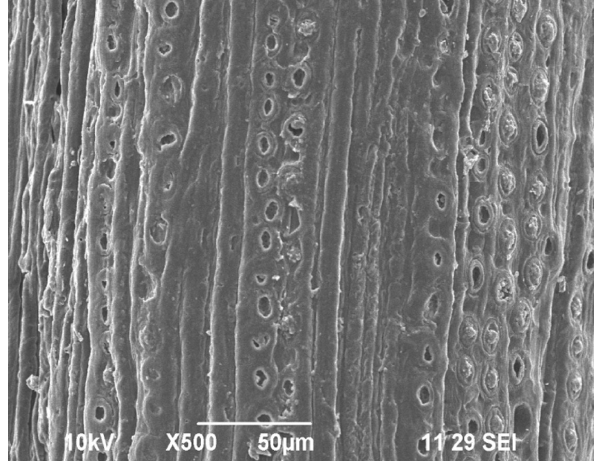
Table 1 Coir fiber tensile strength with NaOH treatment.